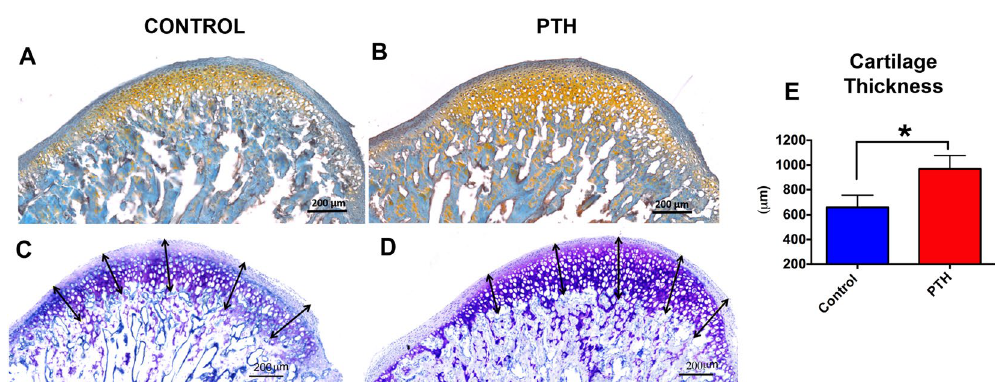
Figure 5. Increased Safranin O and cartilage thickness in the I-PTH group. Sagittal sections of condyles of control ( A ) and I-PTH ( B ) stained for Safranin O. Toluidine blue distance map in control ( C ) and I-PTH ( D ) groups. Histogram showing increased (p < 0.0001) thickness of cartilage in the I-PTH group in comparison to control. * Statistically s ignificant difference between the control and I-PTH